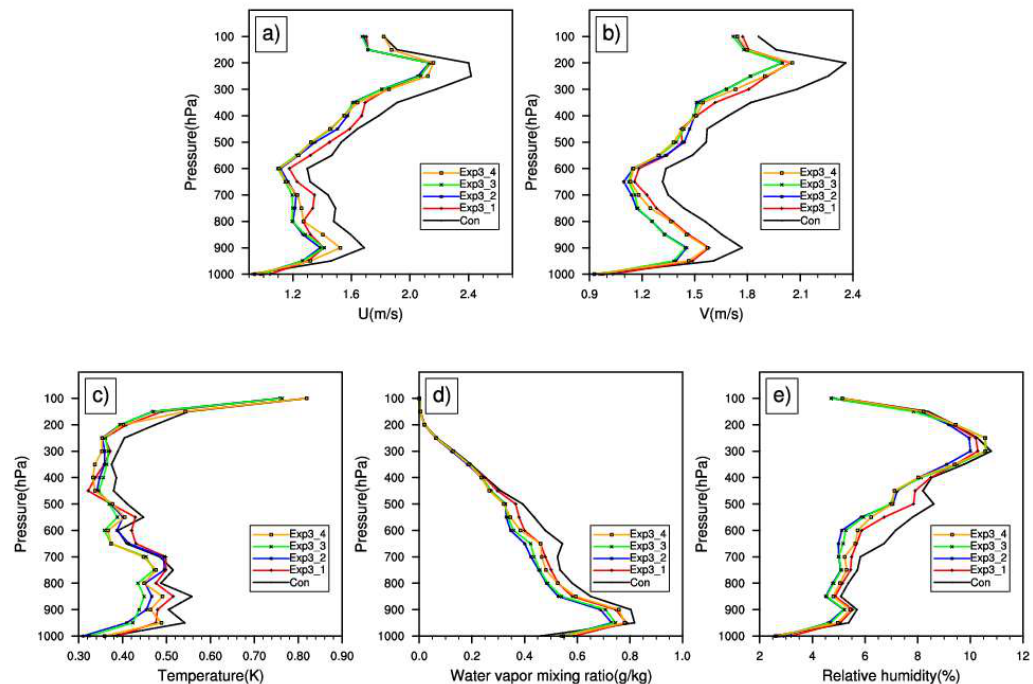
Figure 11. Vertical profiles of RMSEs in ( a ) u winds (unit: m s −1 ) ( b ) v winds (unit: m s −1 ) ( c ) temperature (unit: K) ( d ) water vapor mixing ratio (unit: g/kg) ( e ) relative humidity (unit: %) from the Con, Exp3_1, Exp3_2, Exp3_3, and Exp3_4. Results are valid at 00:00 UTC on 29 June 2009 and are calculated for the whole horizontal domain.